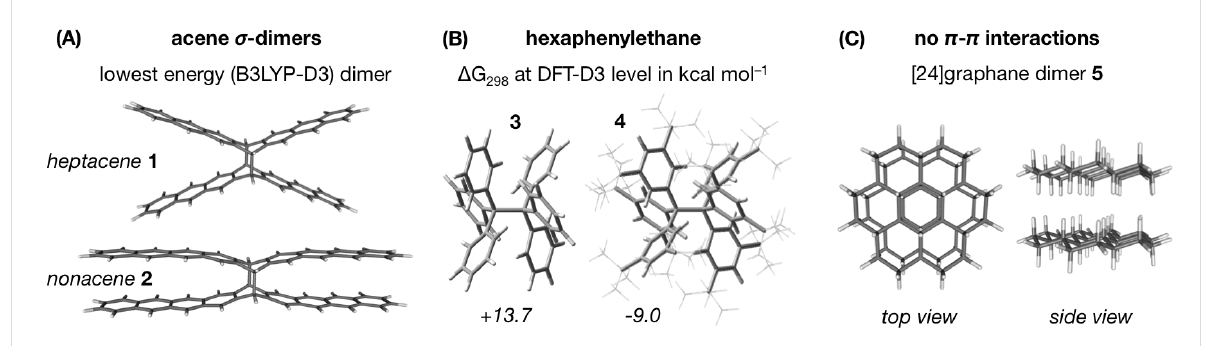
Figure 1: (A) Dispersion is insufficient to bend the heptacene σ -dimer, but becomes sizable enough in nonacene [2]. (B) Bare hexaphenylethane is not thermodynamically stable, but its all- meta - tert -butyl derivative is [3,4]. (C) Thermodynamically stable (at B97D/6-31G(d,p) level) bilayer of a fully saturated hydrocarbon, [24]-graphane